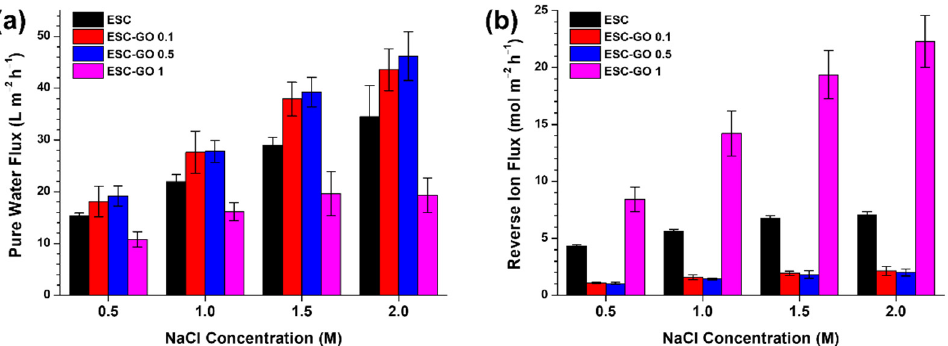
Figure 7. ( a ) Pure water flux and ( b ) reverse ion flux of FO membranes.